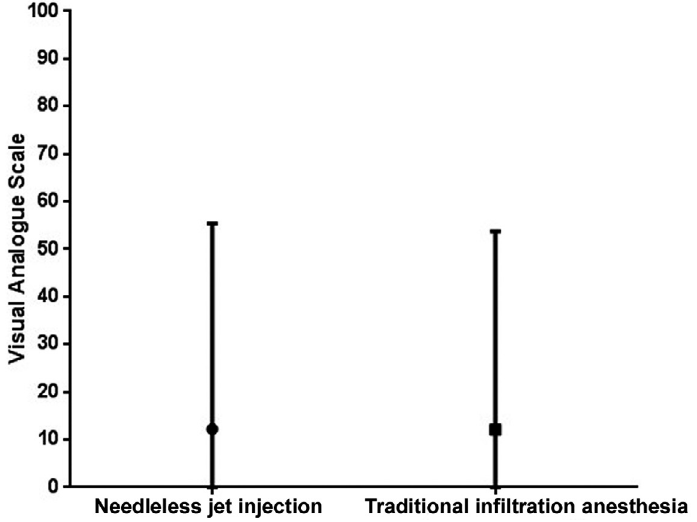
Figure 3- VAS as a function of the degree of pain experienced during administration of anesthesia using the two anesthetic methods in the maxilla. Center bar represents median, maximum, and minimum values. Mann-Whitney test, p>0.05